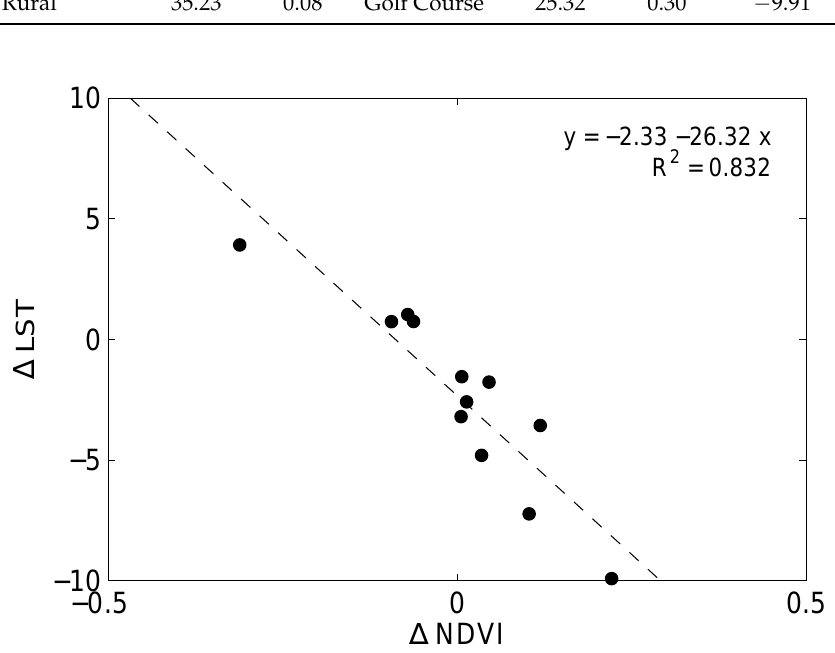
Figure 12. Scatterplot between ∆ NDVI and ∆ LST showing a regression line